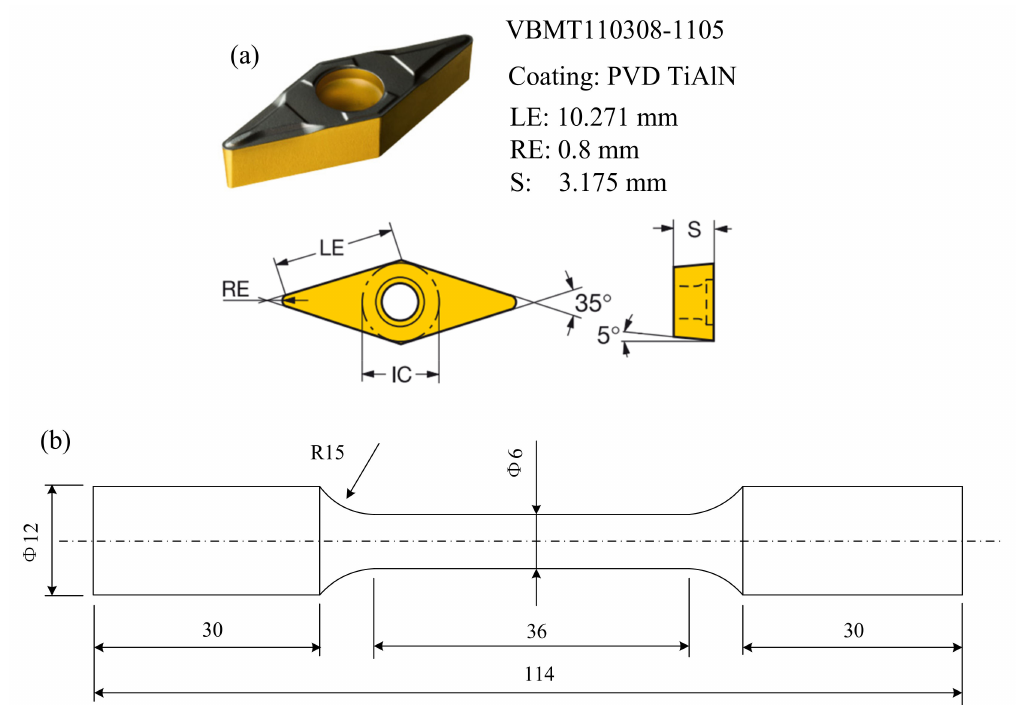
Figure 2. FT experiments: ( a ) the geometry of carbide insert; ( b ) the shape and dimensions of specimen (all dimensions in